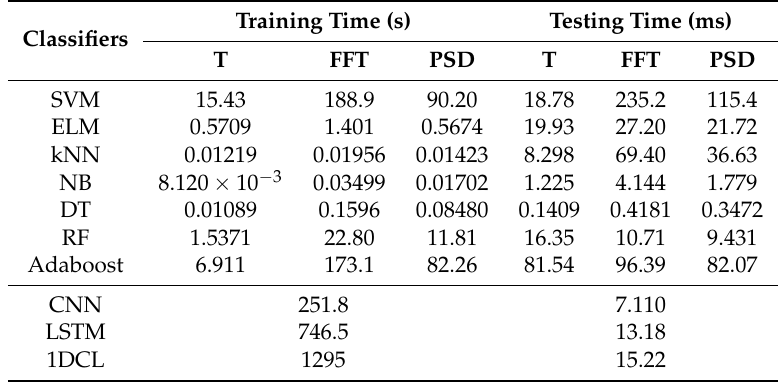
Table 3. Running Time of Feature-Engineering and Feature-Learning